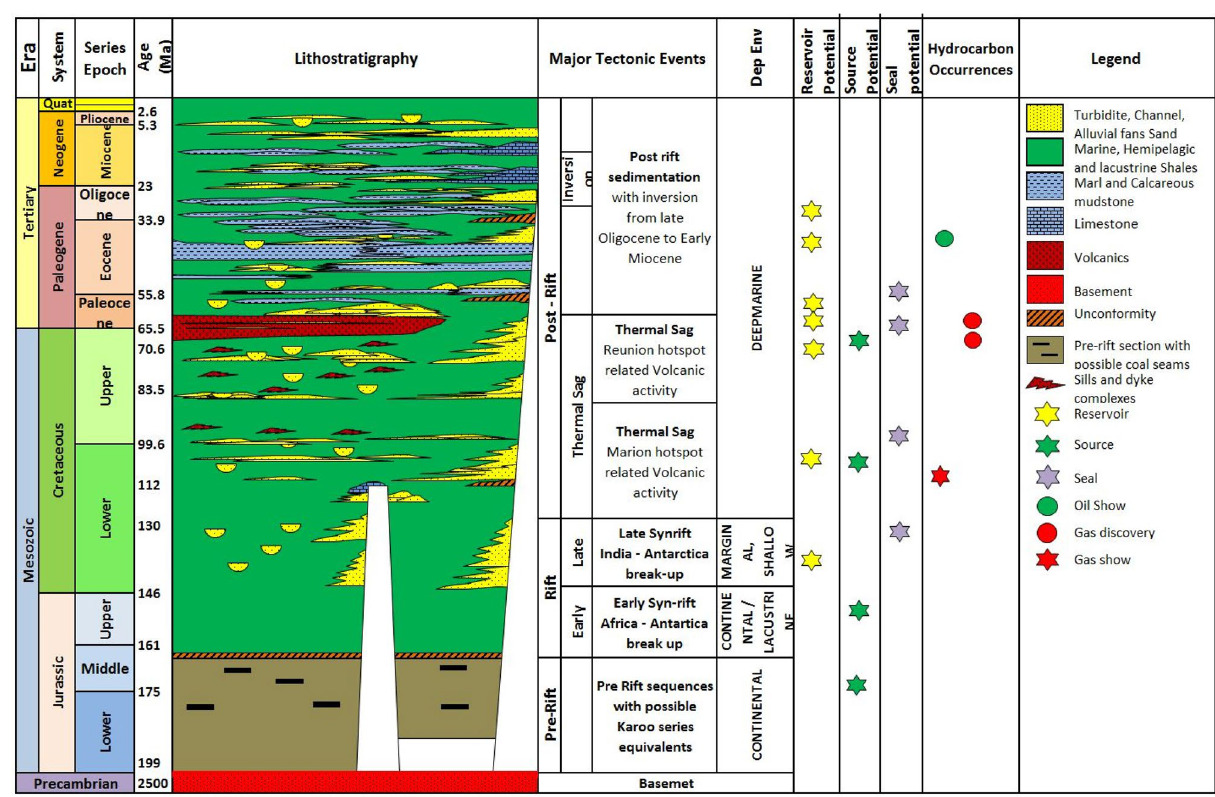
Fig. 4 Generalized stratigraphic column of the Mannar Basin based on the seismic data (SL01, SL05), well data (Pearl 1, Dorado, Dorado North, and Barracuda) and relevant publications (e.g. Ichron 2012a, b,